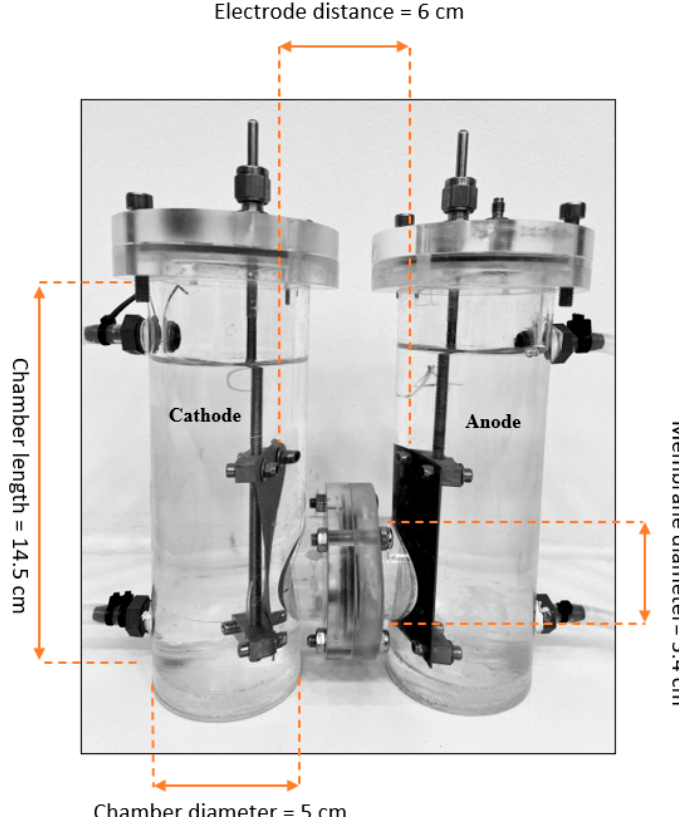
Figure 3. Front view of the electrolytic cell used for the experiments. The cell consisted of two 300 mL cylindrical chambers separated by a cylinder in which the anionic exchange membrane could be placed. The chambers contained the electrolytic solution into which the electrodes, an anode, and a cathode, respectively, were inserted at the distance of 6 cm.